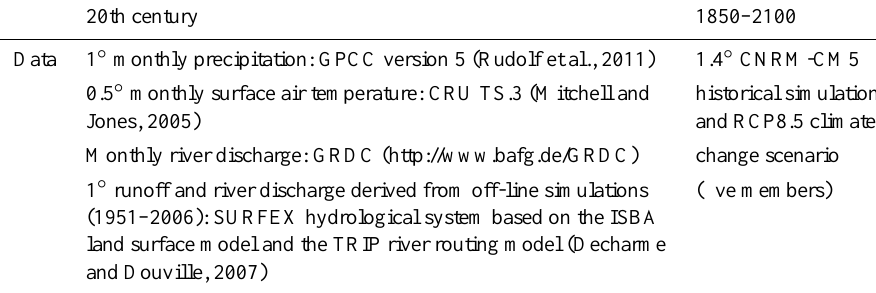
Table 1. Summary of the data sets used in the present study.